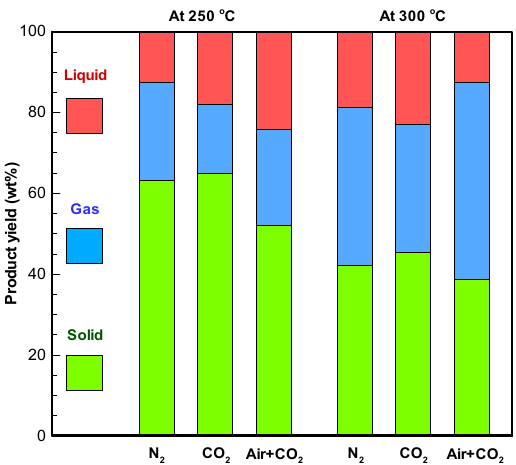
Figure 3. Distributions of product yields from corncob waste